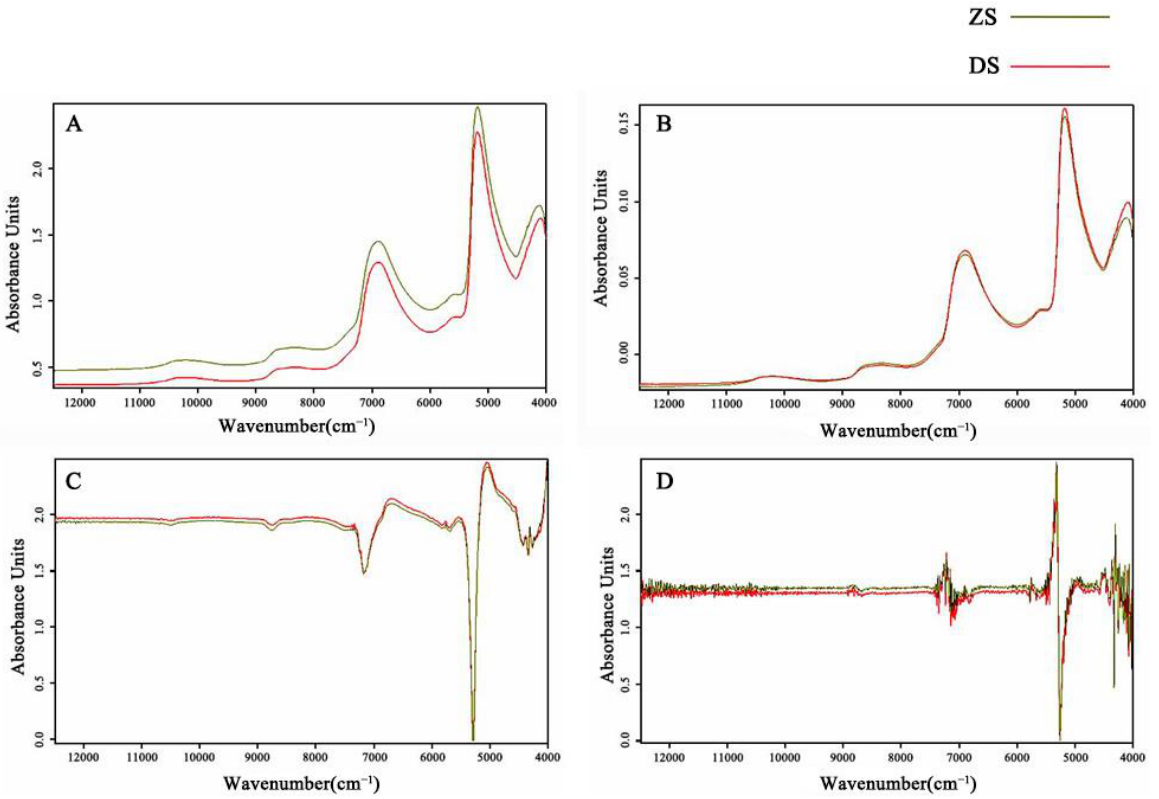
Figure 3. The mean near-infrared spectra ( A ) and the spectra of vector normalizing ( B ), first-order derivative ( C ) and second-order derivative ( D ) of the samples were